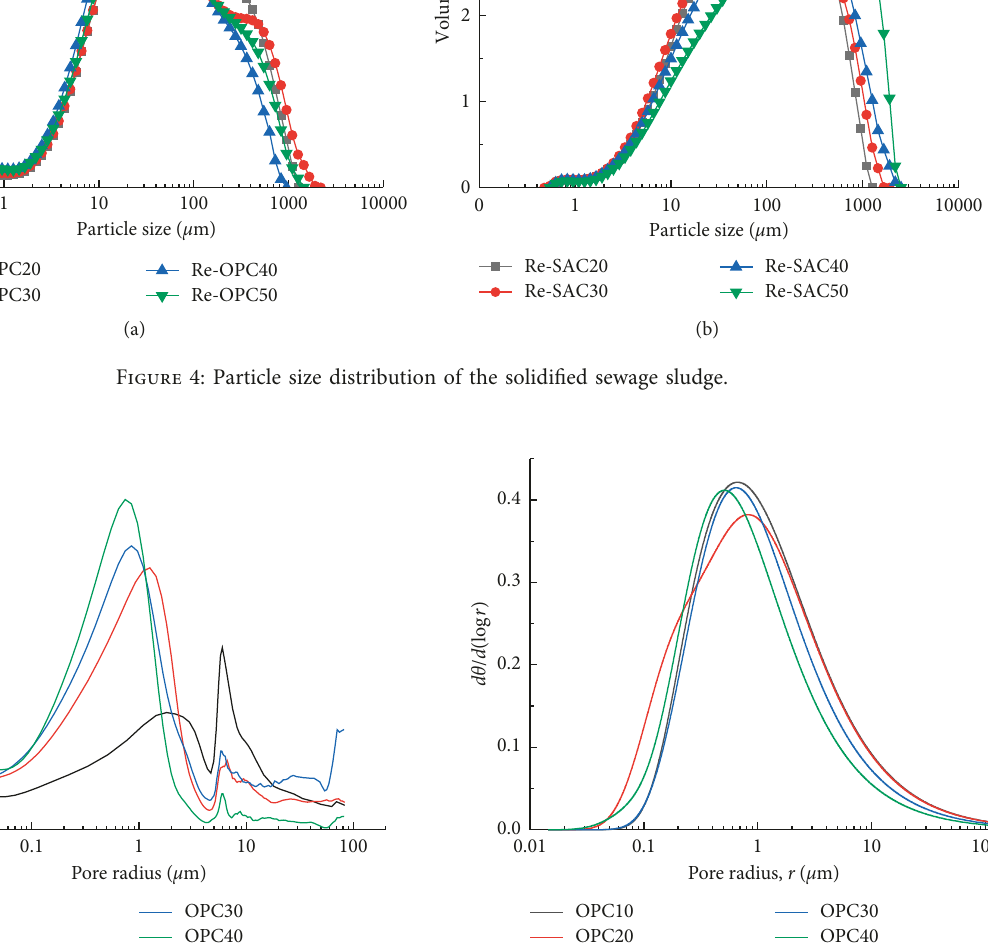
Figure 5: Pore size distribution of OPC-solidified sludge de- termined from MIP tests.